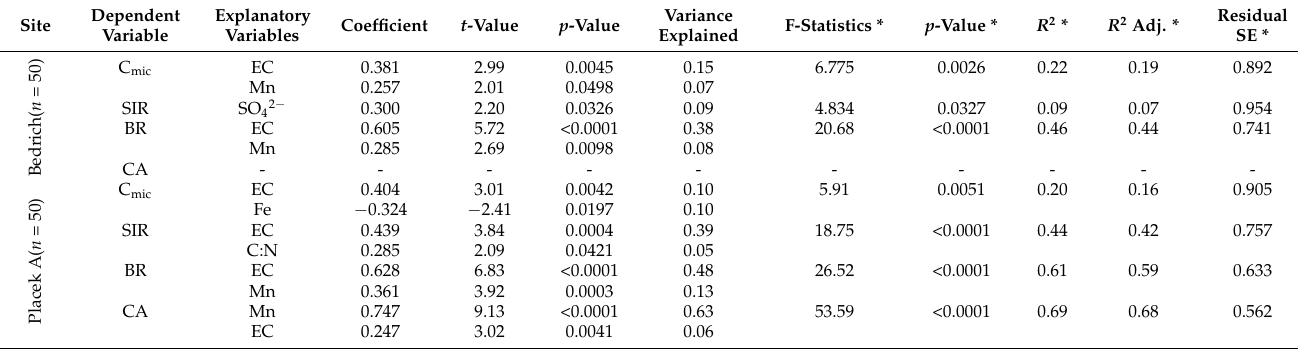
Table 1. Linear regression models of soil biological properties at the two study sites in 2019; separate statistics are provided for the prediction terms (explanatory variables), and for the whole model (indicated with *); C mic = microbial-biomass carbon; SIR = substrate-induced respiration; BR = basal respiration; CA = catalase activity; EC = electrical conductivity; for comparability of regression coefficients, the data were standardized prior to